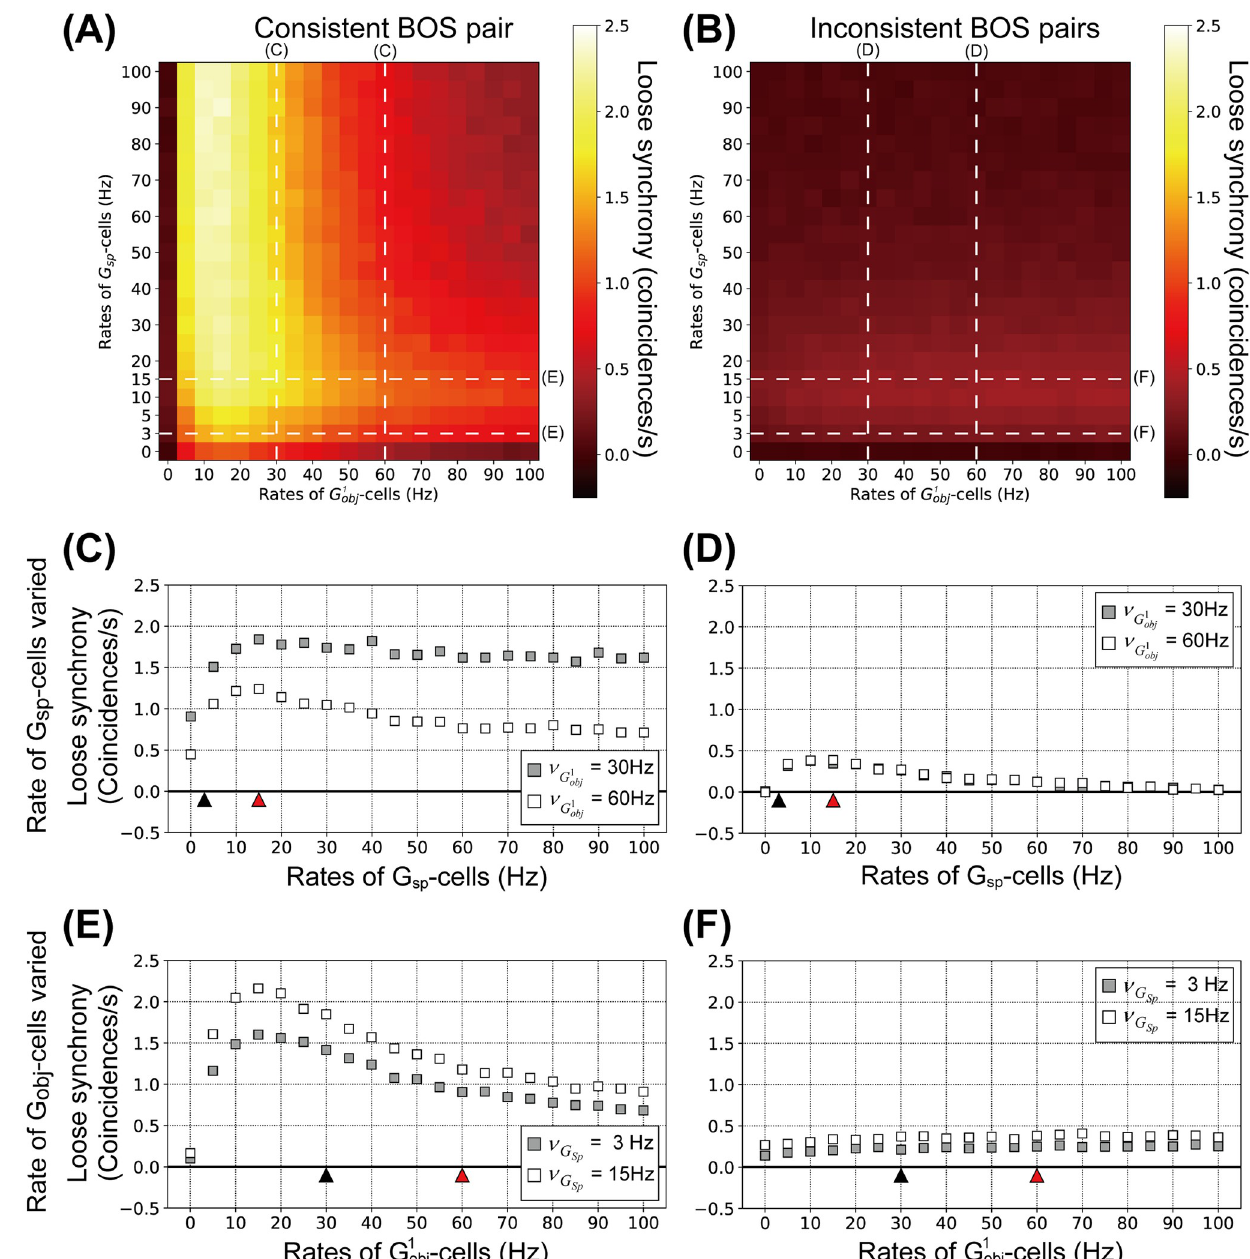
Fig 7. Loose synchrony for model BOS neurons as function of the mean rates of G -cells. Shown is the integral of the spike train cross-correlation in the range of a ± 40 ms interval around lag zero. Each data point is the average of 100 simulated trials, each of 200 biological seconds duration. A: Loose synchrony between BOS 1 and BOS 2 neurons (consistent pair) as a function of combinations of G 1 - and G -cells rates. B: Loose synchrony between all sp R L obj - and G -cells rates. Modulation patterns of loose synchrony inconsistent pairs (defined in Fig 1B) of BOS neurons as function of combinations of G 1 sp obj labelled by white dashed lines with ‘C’, ‘D’, ‘E’ and ‘F’ are summarized in panels C, D, E and F, respectively. C: Loose synchrony between consistent pair as a function of the mean rate of G sp for two different mean rates of G 1 , 30Hz (filled squares) and 60Hz (open squares). Black and red triangles are the same as obj those in Fig 6C. D: Loose synchrony between all inconsistent pairs (defined in Fig 1B) of BOS neurons as function of the rates of G . Note that symbols of sp for 30Hz and 60Hz nearly overlap because there is no direct projection from G 1 -cells to members of the inconsistent BOS cell pairs. Conventions are G 1 obj obj for different mean rates of G , of 3Hz (filled the same as in panel C. E: Loose synchrony between consistent pair as function of the mean rates of G 1 sp obj squares and 15Hz (open squares). Black and red triangles are the same as those in Fig 6E. F: Loose synchrony between inconsistent pairs of BOS neurons as function of the rates of G 1 . Conventions as in panel obj